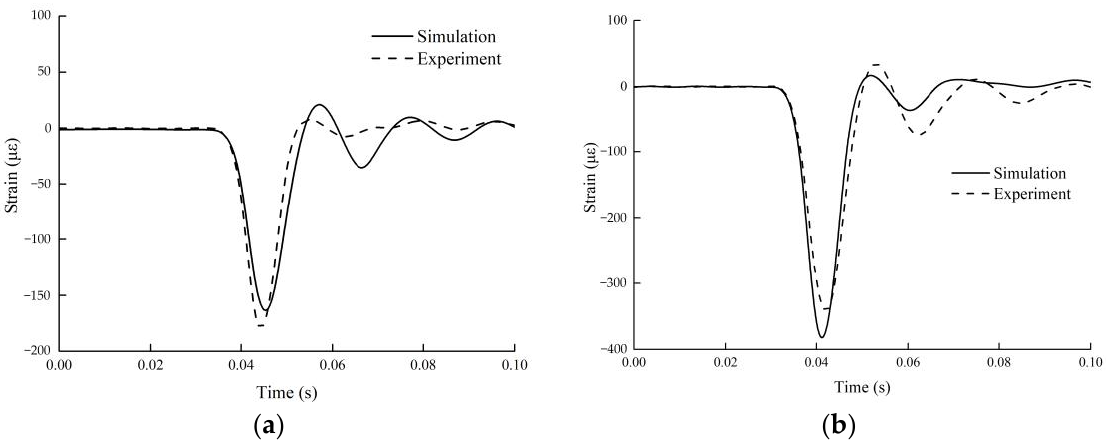
Figure 15. Strain comparison of concrete on backside of C_1: ( a ) drop height = 30 cm and ( b ) drop height = 80 cm.